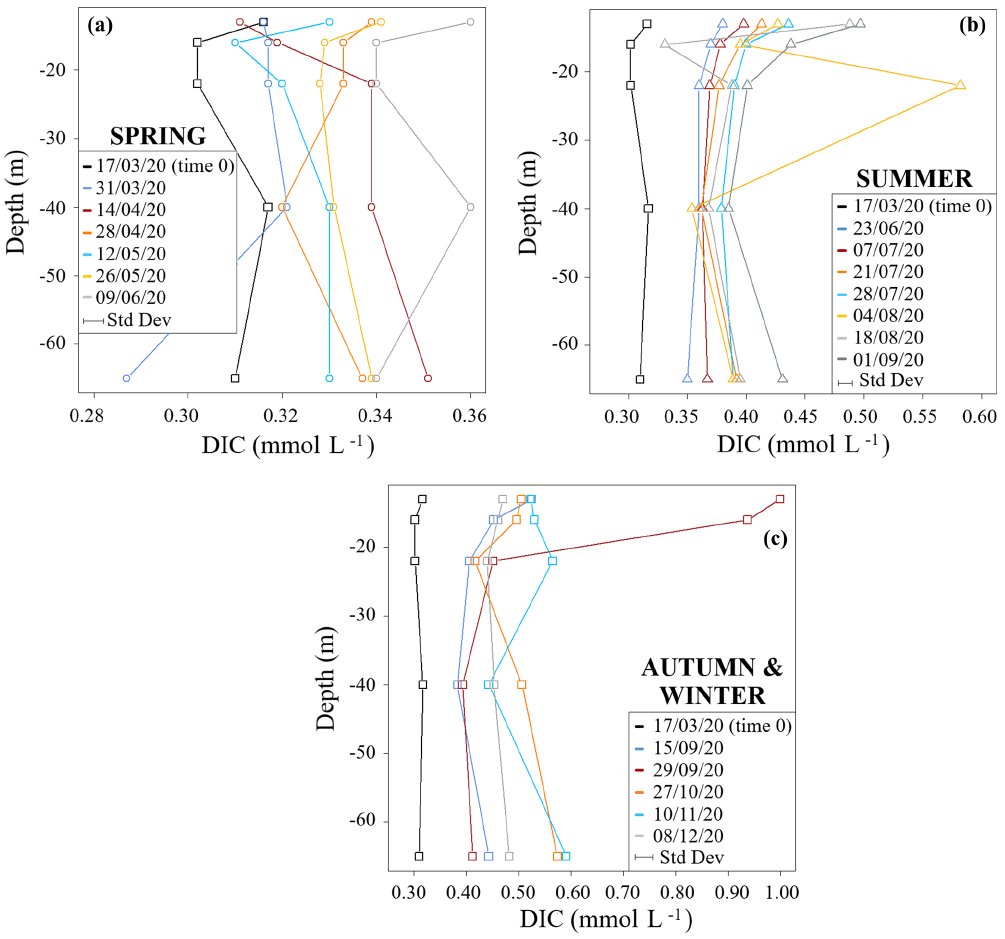
Figure 2. DIC seasonal concentration profiles for (a) spring, (b) summer, and (c) autumn and winter. Standard deviations relative to each dataset ( ± 3%) are reported in the plot below the